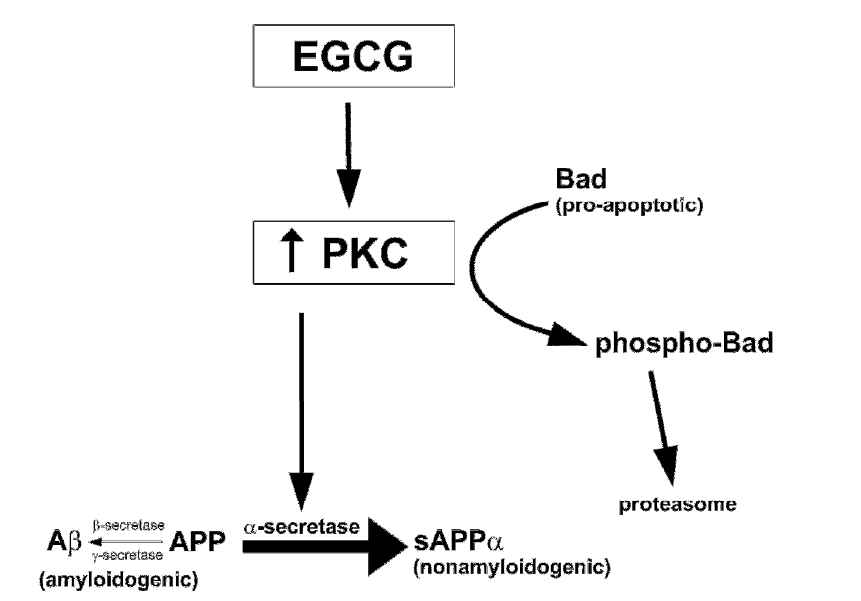
Figure 7. PKC is a key mediator of EGCG neuroprotection. The schematic shows the effects of PKC activation downstream of EGCG on the processing of APP being skewed towards the nonamyloidogenic product, sAPP, and the phosphorylation and targeting of pro-apoptotic Bad for